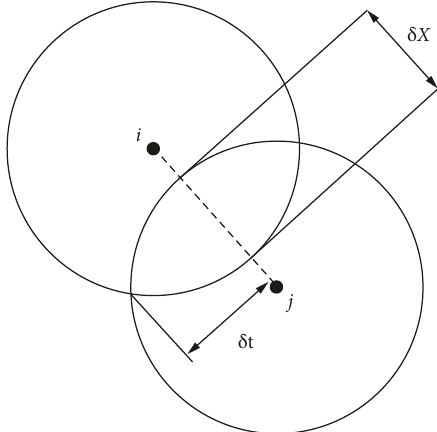
Figure 3: Superposition of particles in